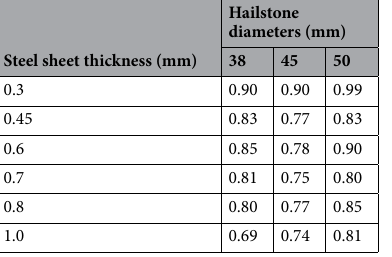
Table 1. β coefficients based on hail diameter and board